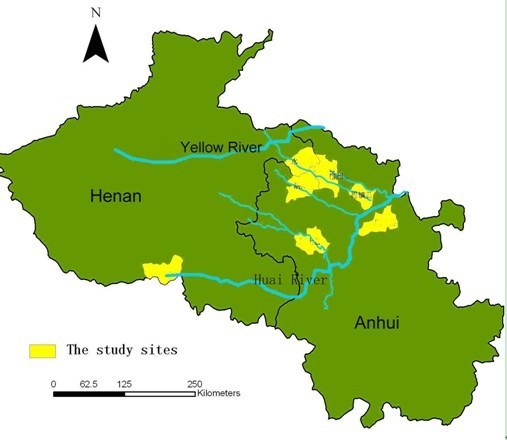
 The map shows the location of the study sites and the Huang-Huai plain.